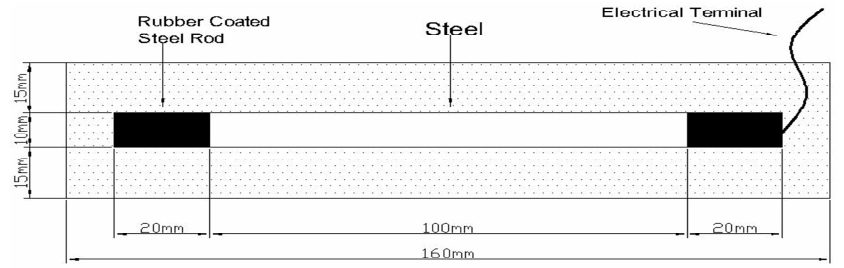
Figure 1. Detailed drawing of mortar specimens. Table 1. Oxide composition of cement used (% by mass).